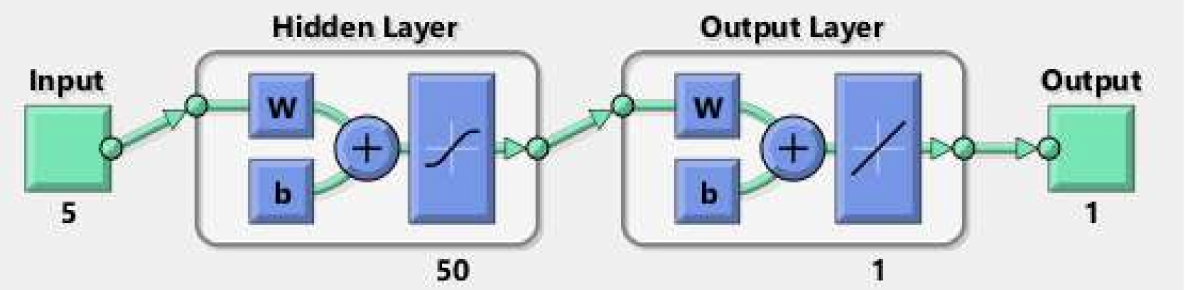
Figure 4. Structure of the neural